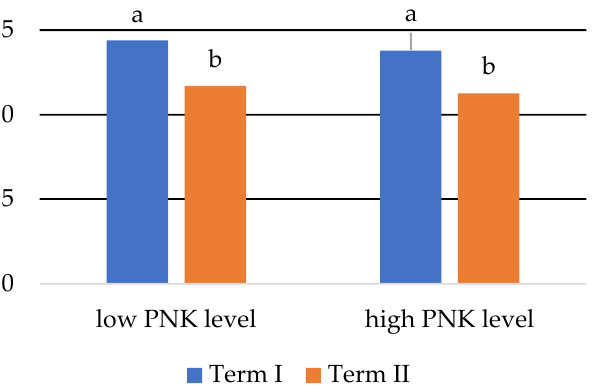
Figure 3. The indicator of cadmium contamination in Hydrocharis morsus-ranae in the three tested growing seasons. Similar letter indicates no significant difference ( p ≤ 0.05).